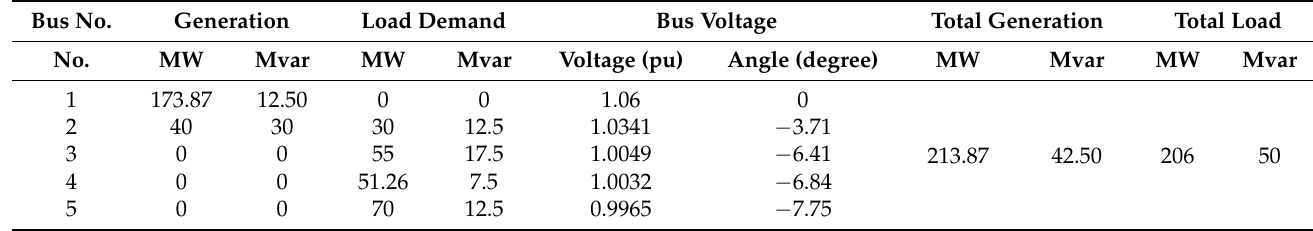
Table 2. Load flow results of the IEEE 5 bus system of case 1.